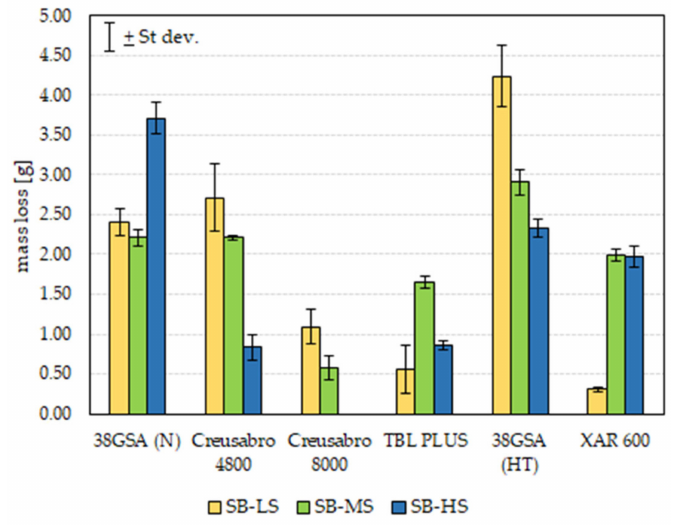
Figure 1. The mass wear of the tested samples over a friction distance of 20,000 m in various kinds of abrasive soil masses. SB-LS—“spinning bowl” method, light soil; SB-MS—“spinning bowl” method, medium soil; SB-HS—“spinning bowl” method, heavy soil; N—as-normalized condition, HT—as-hardened condition [22–24].